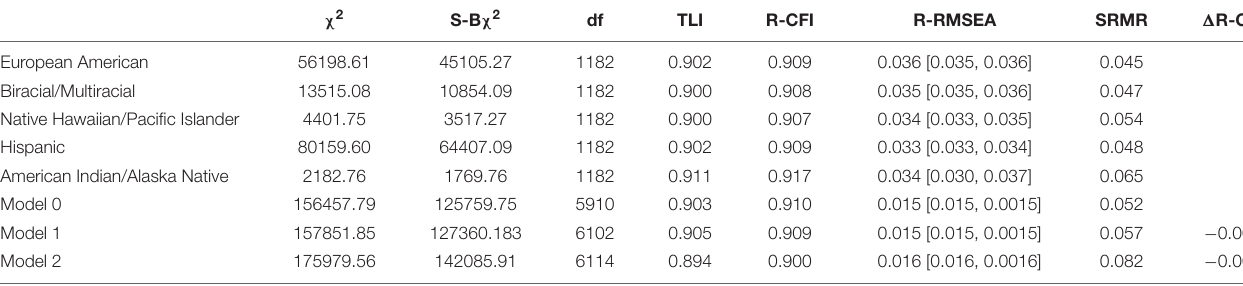
TABLE 6 | Goodness-of-fit indices for invariance of the trimmed model across ethnic group. χ